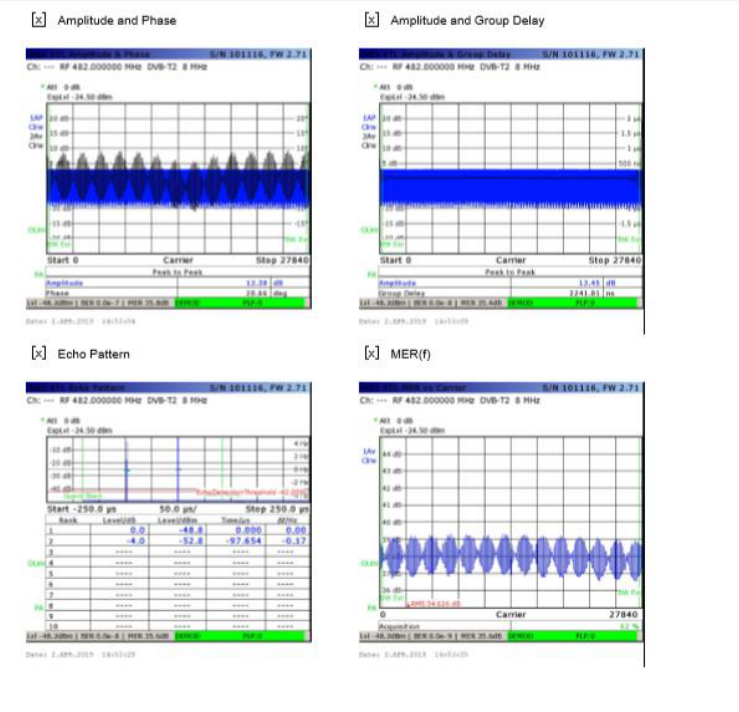
Figure 17. DVB-T2 Signal Form and Values parameters measured in the SFN mode: Level -48.8 dBm; Δ Level, -4.0 dB Amplitude 13.48 dB; Phase 27.17 deg; MER(f); MER (PLP, rms) 33.6 dB; Time offset 100